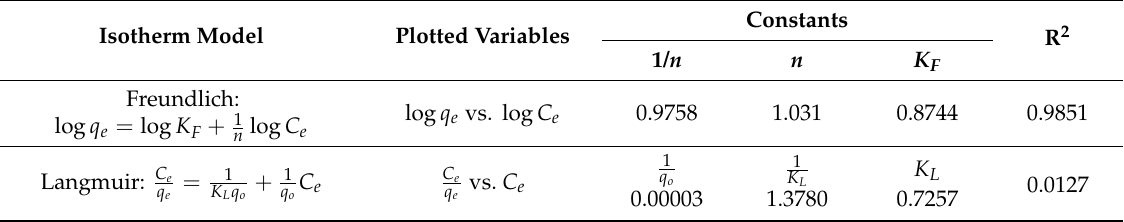
Table 7. Important constants of the isotherm models and fitness correlation.